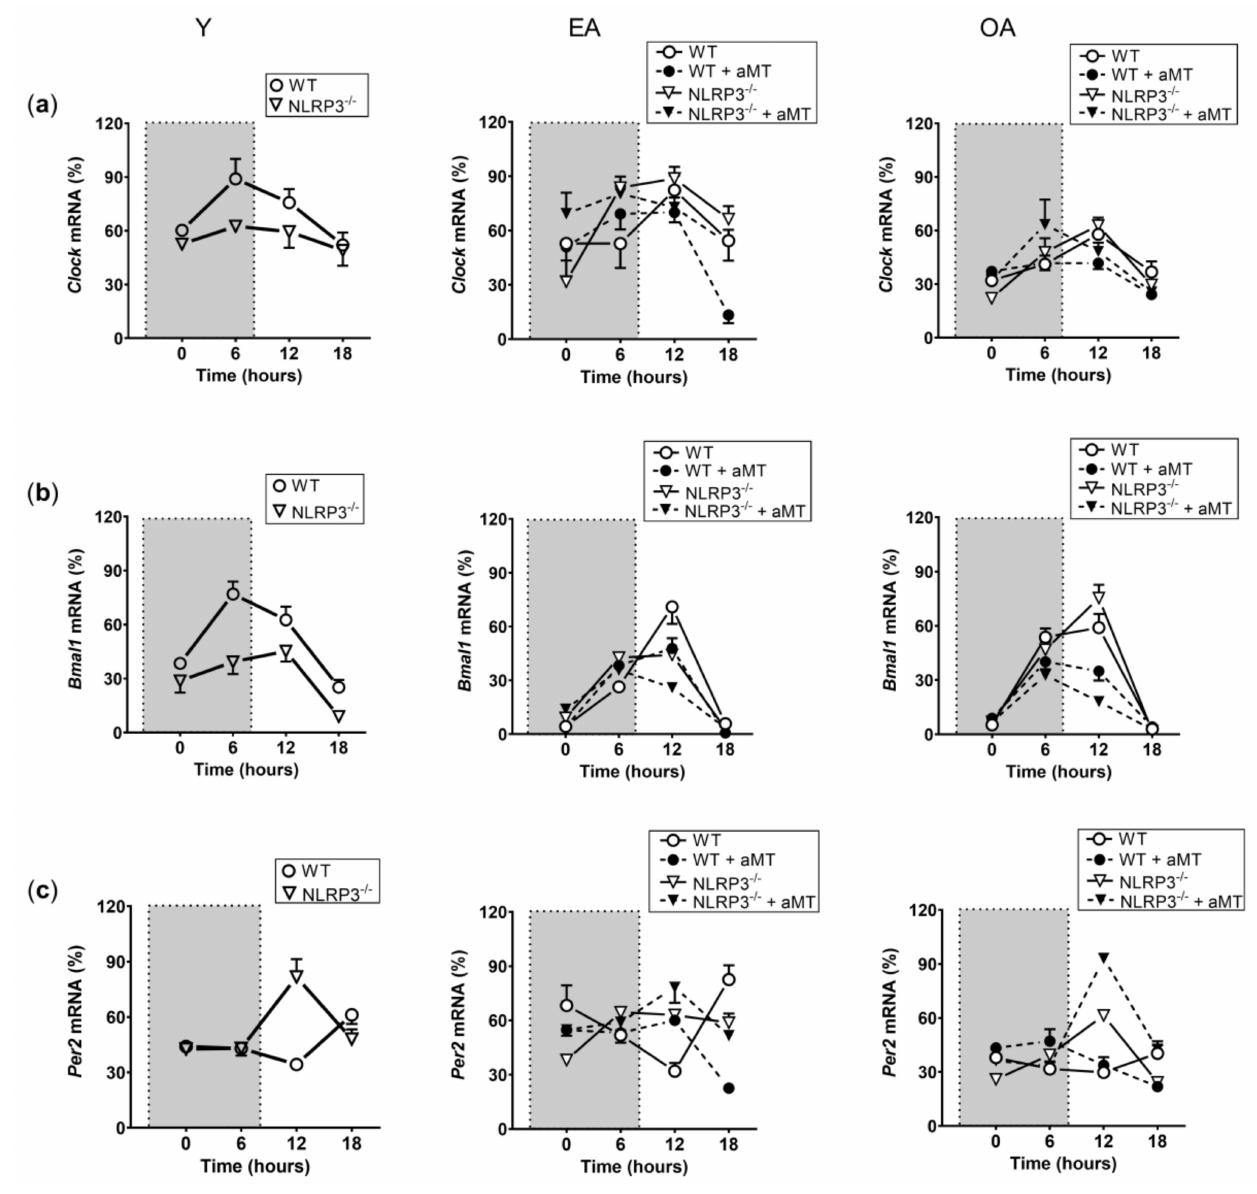
Figure 1. Changes in the relative expression of the Clock , Bmal1 , and Per2 transcripts in WT and NLRP3 − / − mice during aging and melatonin treatment. Relative expression of the Clock ( a ), Bmal1 ( b ), and Per2 ( c ) transcripts in hearts of young (Y), early-aged (EA), early-aged with melatonin (EA + aMT), old-aged (OA), and old-aged with melatonin (OA + aMT) wild type and NLRP3 − / − mice and their daily patterns at 4 time points (00:00, 06:00, 12:00, and 18:00 h) under a 12 h/12 h light/dark cycle. The shaded region on each graph represents constant darkness. Data are expressed as means ± SEM (n = 6 animals/group). Data of significant differences among the experimental groups were evaluated by Tukey multiple comparison of mean post hoc test following ANOVA, and they are detailed in Supplementary Table S1: Table S1.1 ( Clock ), S1.2 ( Bmal1 ), S1.3 ( Per2